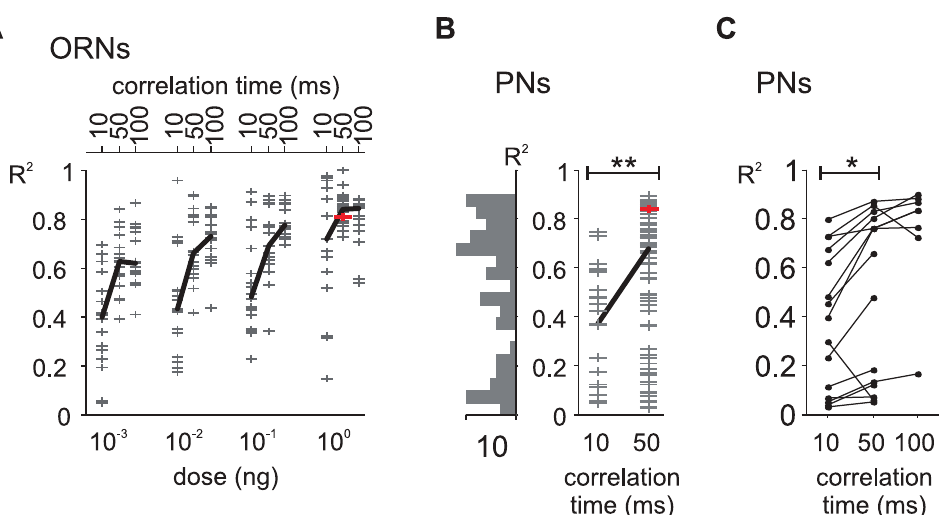
Fig 3. Performances of L-N model predictions. (A) Distributionof coefficient of determination R 2 between model predictionand ORN responses to white-noise stimuli. Grey crosses: individualcells. The exampleORN from Fig 1B and 1C is shown with a red symbol. Black segment: median values. R 2 dependsboth on noise correlation time (ANOVA, p < 10 − 10 ) and pheromoneload (ANOVA, p < 10 -10 ). (B) Distributionof R 2 between model predictionand PN responses to noise stimuli, independent samples, n = 97 cells. Left: the distribution histogram shows the heterogeneity of R 2 values. ** : p < 0.01Wilcoxon’srank sum test. The examplePN from Fig 1D and 1E is shown with a red symbol. (C) R 2 betweenmodel predictionand PN responses to noise stimuli, pairedsamples. For this data set (n = 15 cells), two or three noise sequenceswith different correlation times were tested for each cell. Line segments join the R 2 calculatedfor the same cell. * : p < 0.05Wilcoxon’s signed rank test. The values in responseto the 50 ms correlation time are includedin (B).